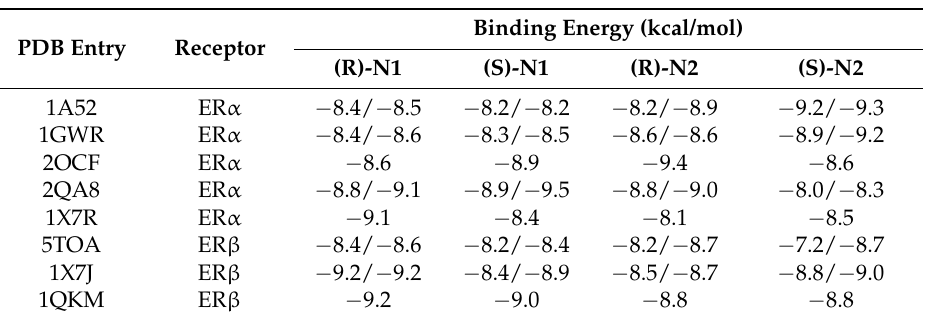
Table 1. Binding energies for N1 and N2 in both enantiomeric forms complexed with ER α and ER β . Docking performed by using AutoDock Vina [31], followed by a minimization refinement for the complex obtained. Results for receptors in dimeric form are reported with two values corresponding to chain A and B, respectively.